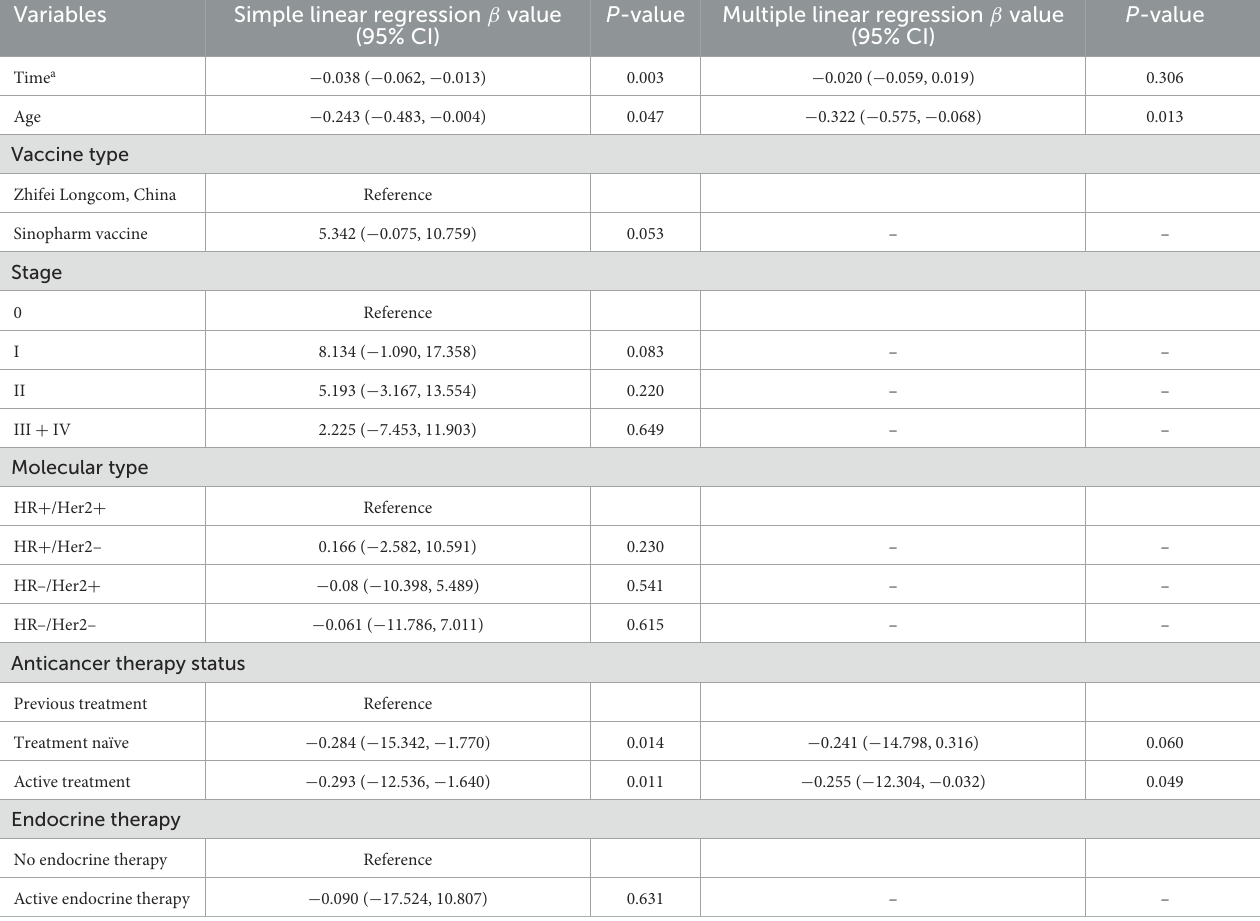
TABLE 2 Simple and multiple regression analyses to identify risk factors of lower anti-RBD titers in breast cancer patients.